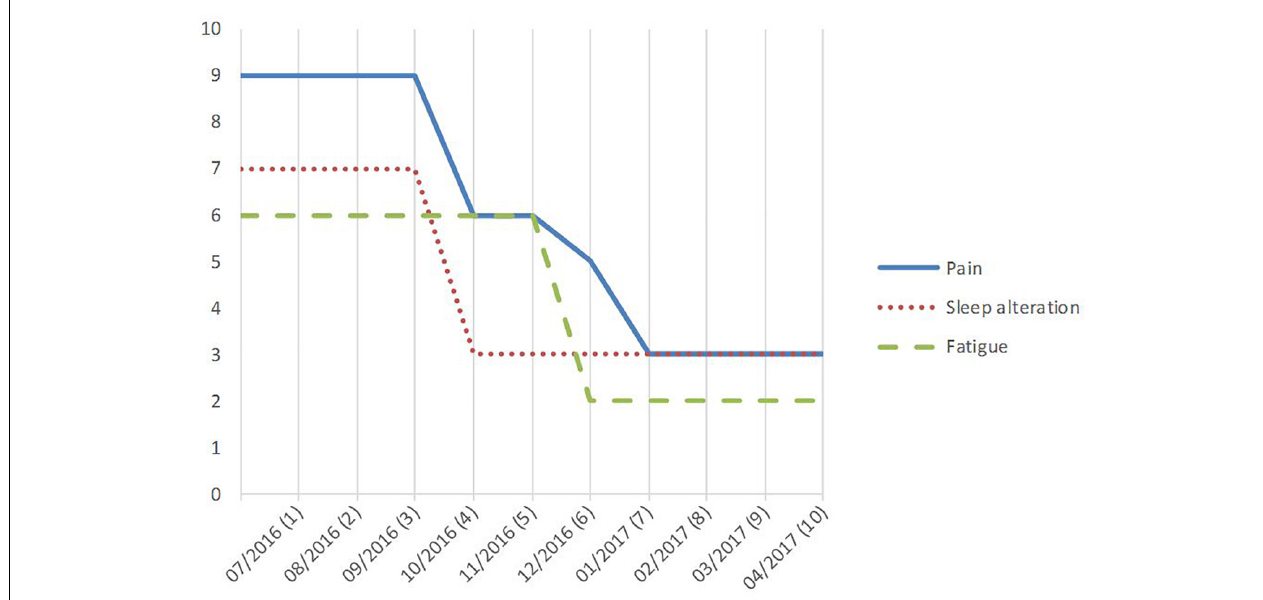
FIGURE 2 | Evolution of average intensity of pain, sleep alteration, and fatigue on a 0–10 numeric rating scale (NRS), between before and the week after 10 monthly sessions (1–10) of repetitive transcranial magnetic stimulation (rTMS) delivered to the right motor